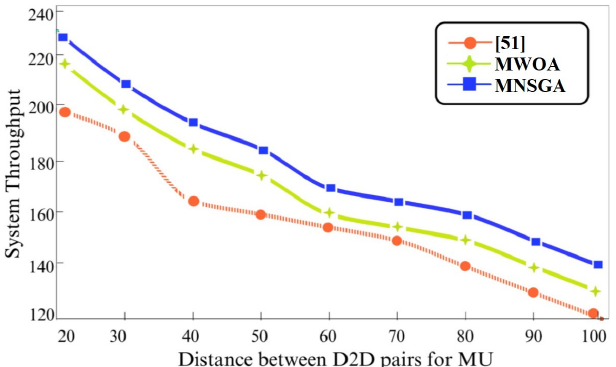
Figure 9. Throughputs for various distances between D2D pairs for MU s [51].